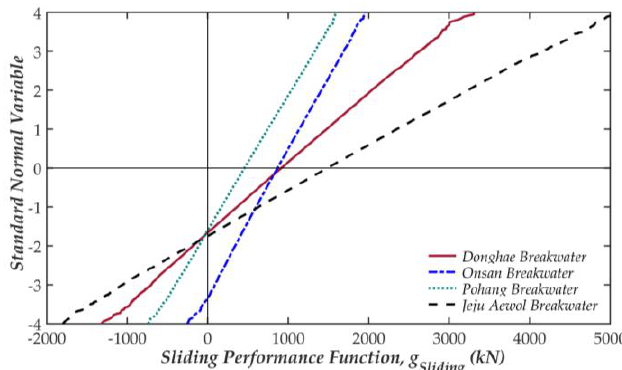
Figure 8. Cumulative density of the sliding performance function (PF) in the standard normal space.